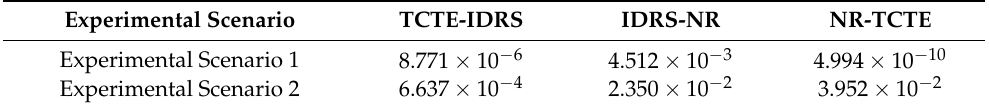
Table 3. p -values of the t-test for the average NDC download delay with 60 users. Experimental